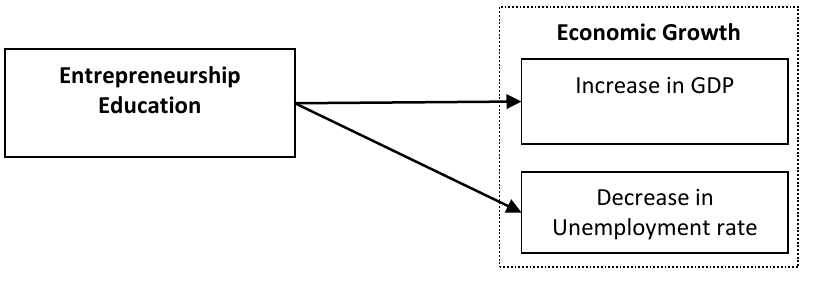
Figure 2: The Research